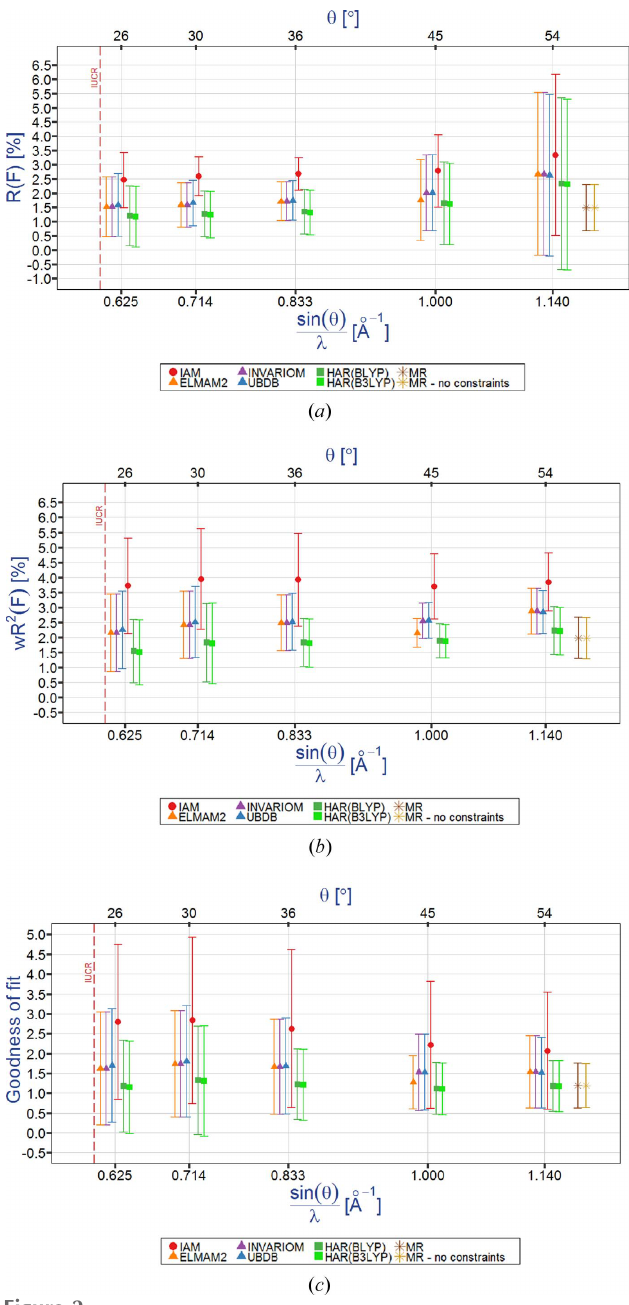
Figure 2 Discrepancy factors and GoF versus resolution and electron density model: ( a ) dependence of R ( F ), ( b ) wR 2 ( F ) and ( c ) GoF. MR stands for multipole refinement, no constraints refers to hydrogen atom